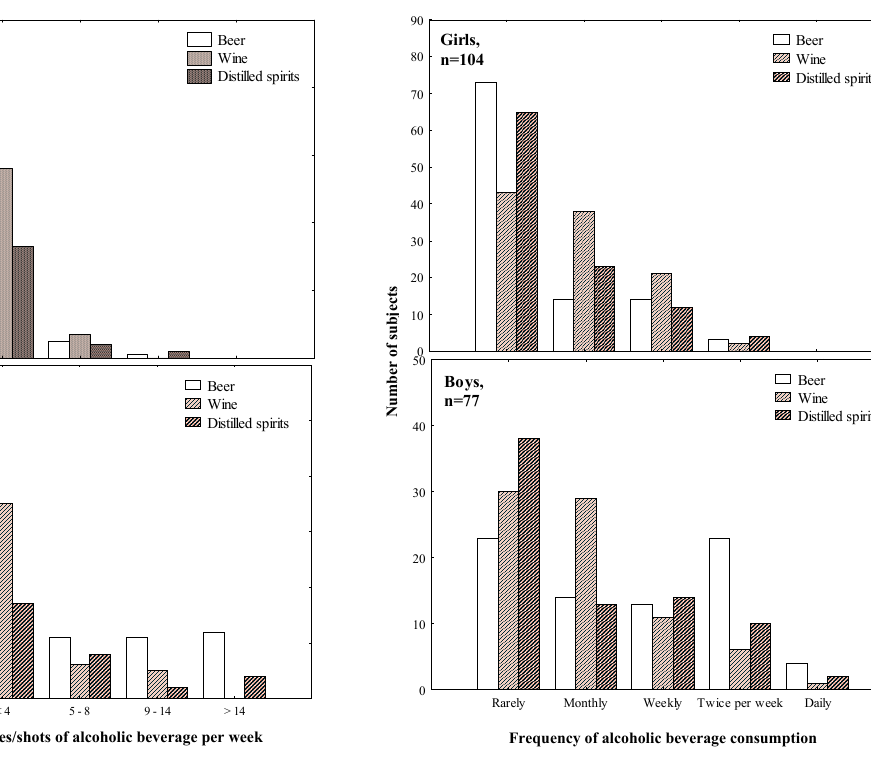
Figure 1. The frequency distributions of the alcohol consumption intensity, stratified according to gender.